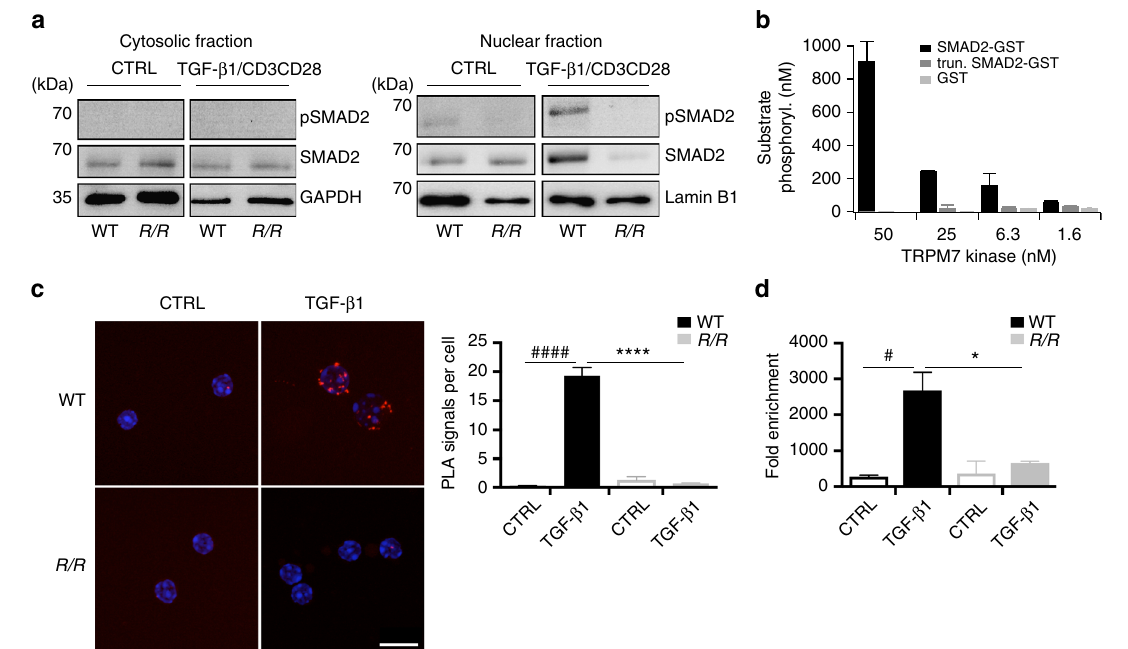
Fig. 6 TRPM7 kinase affects SMAD2 translocation via direct phosphorylation. a Analysis of pSMAD2 translocation into the nucleus. WT and Trpm7 R/R naive CD4 + T cells were co-stimulated with α CD3/ α CD28 and 5 ng ml − 1 TGF- β 1 for 10 min. Representative western blot images depicting that pSMAD2 and total SMAD2 in the nuclear fraction (right) were strongly reduced in Trpm7 R/R T cells compared to WT. In the respective cytosolic fraction (left), the pSMAD2 was not detectable, however amounts of total SMAD2 were comparable between Trpm7 R/R and WT. b Concentration-dependent phosphorylation of human recombinant SMAD2-GST by TRPM7 kinase. Data have been obtained via RBC hotspot in vitro kinase assay using 4 µ M ATP and 4 µ M substrate at 2 h. RBC standard substrate was used as a positive control, substrate alone as a negative control and kinase activity alone was subtracted as background. Data have been converted to nM substrate phosphorylation and are plotted as mean ± s.e.m. Truncated recombinant SMAD2 (trun. SMAD2-GST) as well as the GST-tag alone were not phosphorylated, suggesting speci fi c phosphorylation of SMAD2 at the c-terminal SXS motif. c Analysis of interaction between SMAD2 and TRPM7 in CD4 + T cells via proximity ligation assay (PLA). Scale bar indicates 10 µ m. Note a signi fi cant increase in SMAD2 co-localization with TRPM7 in WT T cells treated with 5 ng ml − 1 TGF- β 1 ( #### p < 0.0001; two-tailed Student ’ s t test). Trpm7 R/R T cells fail to recruit SMAD2 into close proximity to the TRPM7 kinase upon TGF- β 1 stimulation compared to WT (**** p < 0.0001; two-tailed Student ’ s t test). Bar graphs show mean PLA signals per cell counted in fi ve fi elds of vision ± s.e.m. d ChIP assay was performed in untreated and TGF- β 1 (5 ng ml − 1 ) stimulated CD4 + T cells using a speci fi c antibody against SMAD2 for immunoprecipitation. Primers for Itgae and Gapdh were used for qRT-PCR; Gapdh was used for normalization. Note a signi fi cant increase in -fold enrichment in TGF- β 1-treated WT T cells compared to untreated controls ( # p < 0.05, one-way analysis of variance) as well as a reduction in fold enrichment of TGF- β 1-treated Trpm7 R/R T cells compared to WT (* p < 0.05, one-way ANOVA). Bar graphs show mean ±